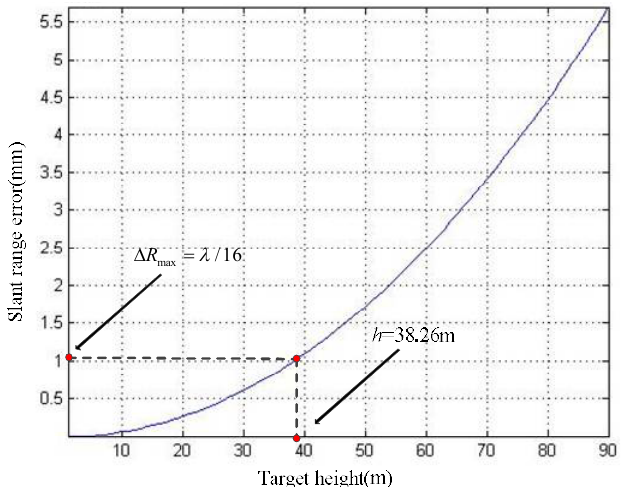
Figure 4. The h –∆ R max relationship curve.